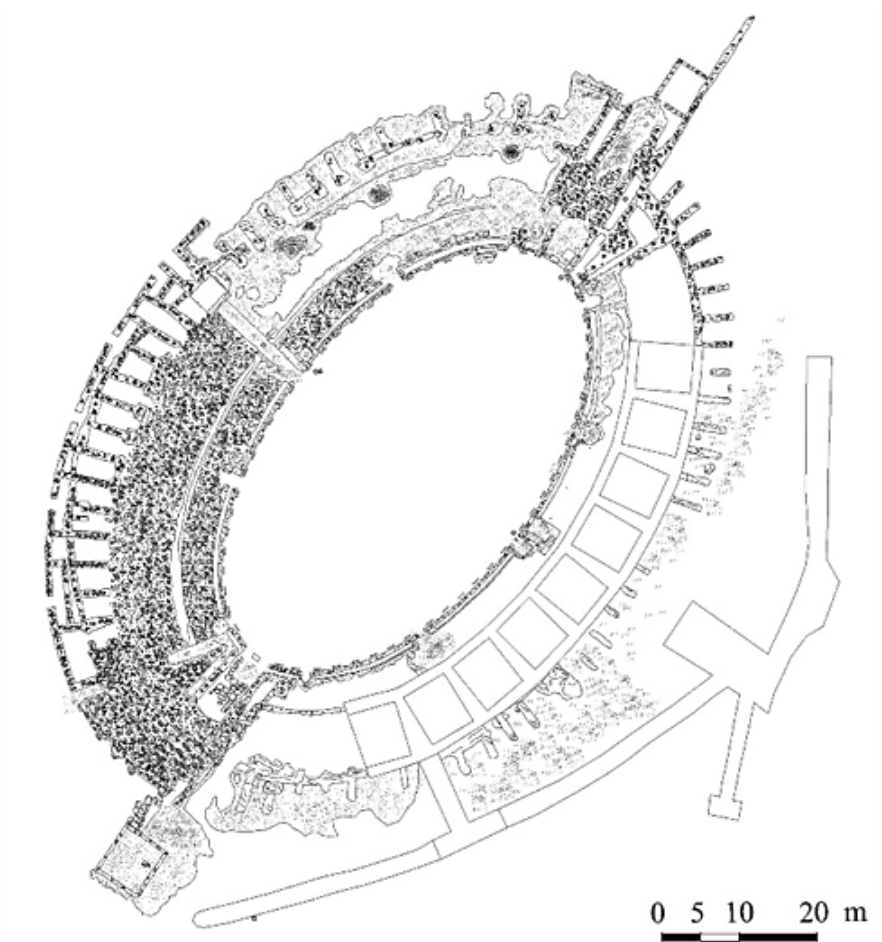
Figure 13: Top view of the Amphitheatre of Avella (edited by Francesco Mele in scale